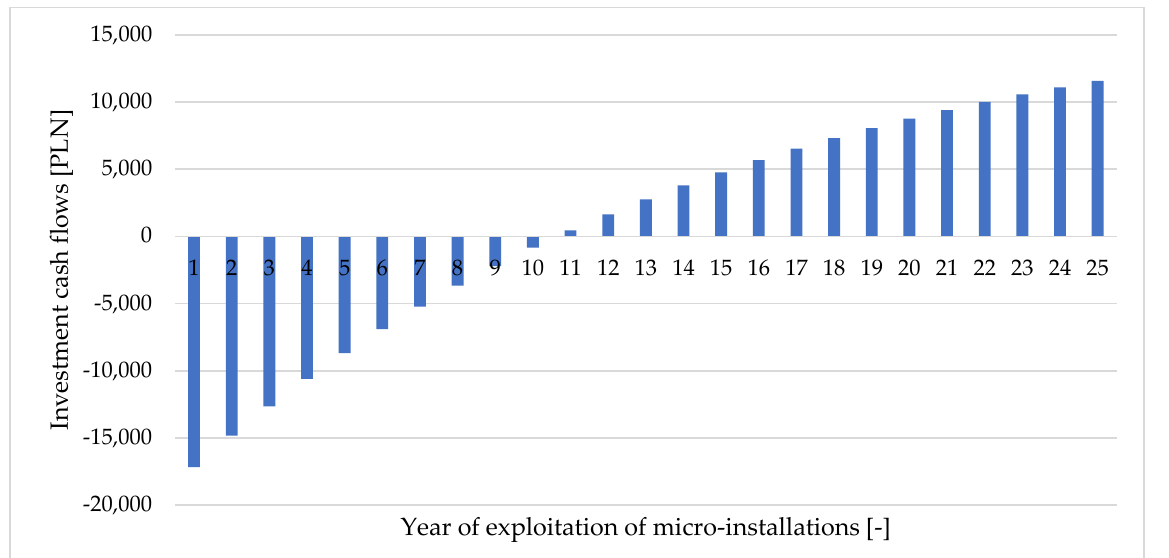
Figure 14. Graph showing the investment cash flow as a function of time of operation for the net-billing system based on monthly prices and a 60% self-consumption level. When analysing the increased level of electricity self-consumption from 50% to 60%, an increase in NPV values for the energy billing systems at monthly and hourly prices is observed. For the discount system, the NPV changes only slightly, as in the previously analysed case. A 10% increase in the level of current energy consumption resulted in a reduction in payback time of three years for energy billing at monthly prices and as much as six years for hourly prices. With 60% self-consumption of electricity, the investment payback period when billing electricity at hourly prices and according to the principle of discounts practically became almost equal and amounted to approximately 10–11 years, but the final value of the NPV is approximately 2.5 times